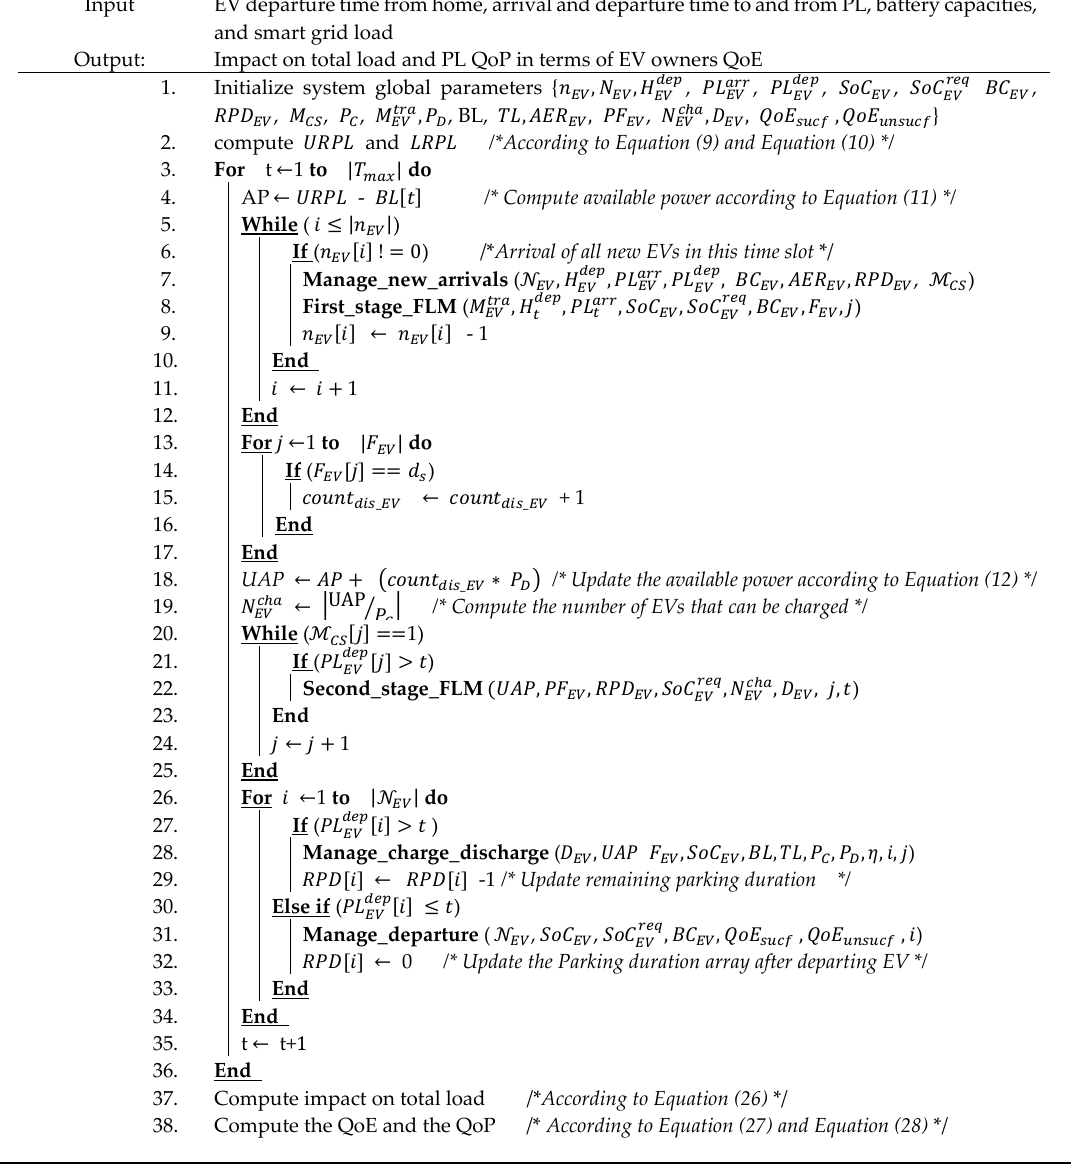
Table 5. IEEE 34 node test feeder- spot